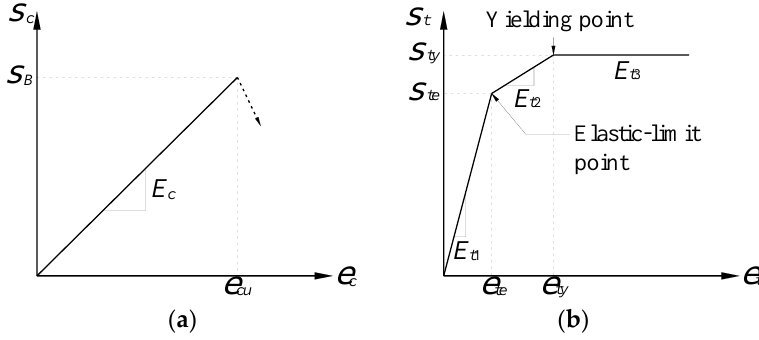
Figure 5. Constitutive model: ( a ) high-strength concrete; ( b ) tendons.